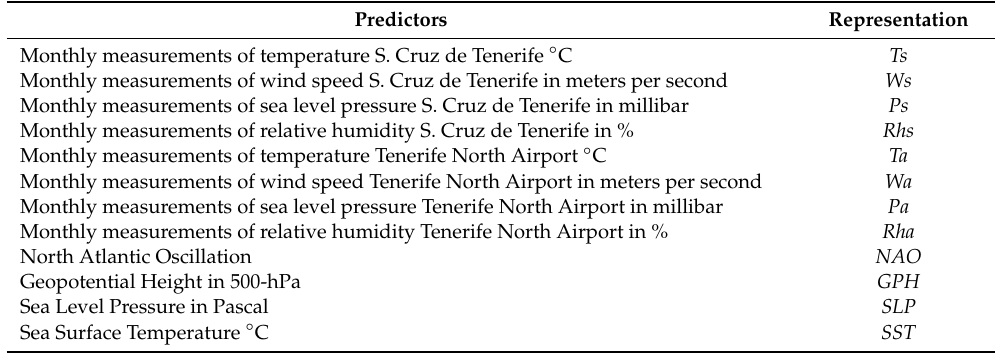
Table 2. Shortlisted predictors and their